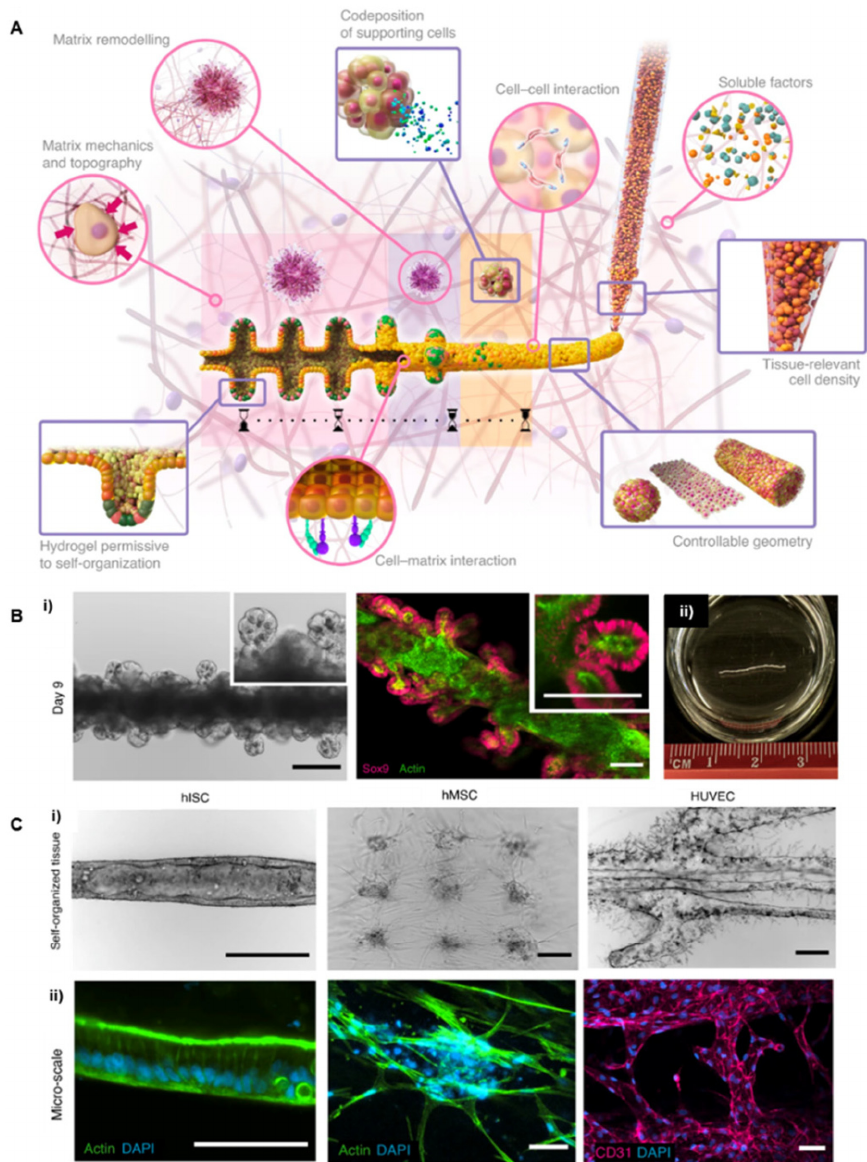
Figure 9. Bioprinting high cellular densities inside hydrogels. Reprinted with permission from Ref. [22]. Copyright 2020, Springer Nature. ( A ) Macroscopic intestinal printing principle. Multicellu- lar self-organization was achieved directly inside the hydrogel environment. ( B ) (i) Bright-field and confocal microscopy of the intestinal tube showing stem cells forming the crypts on Day 9. Scale bars, 200 µ m (left), 100 µ m (right). (ii) Image of a centimetric intestinal tube. ( C ) Bright-field and confocal microscopy of the embedded patterns of hISC, hMSC, and HUVEC cells. (i) Bright-field images. Scale bars, 500 µ m. (ii) Cells were labeled with DAPI (blue) and F-actin (green) or CD31 (pink). Scale bars, 250 µ m (left) and 75 µ m